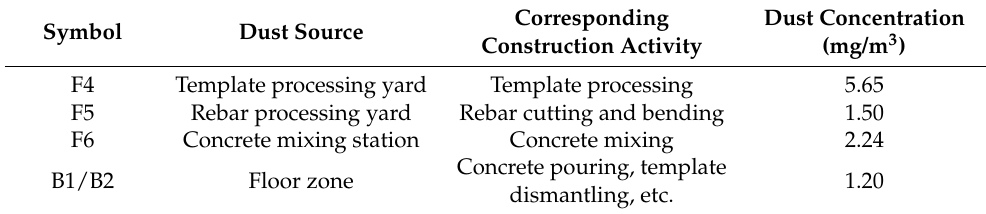
Table 2. Number of workers at the corresponding workplaces. Table 3. Mean concentration of dust